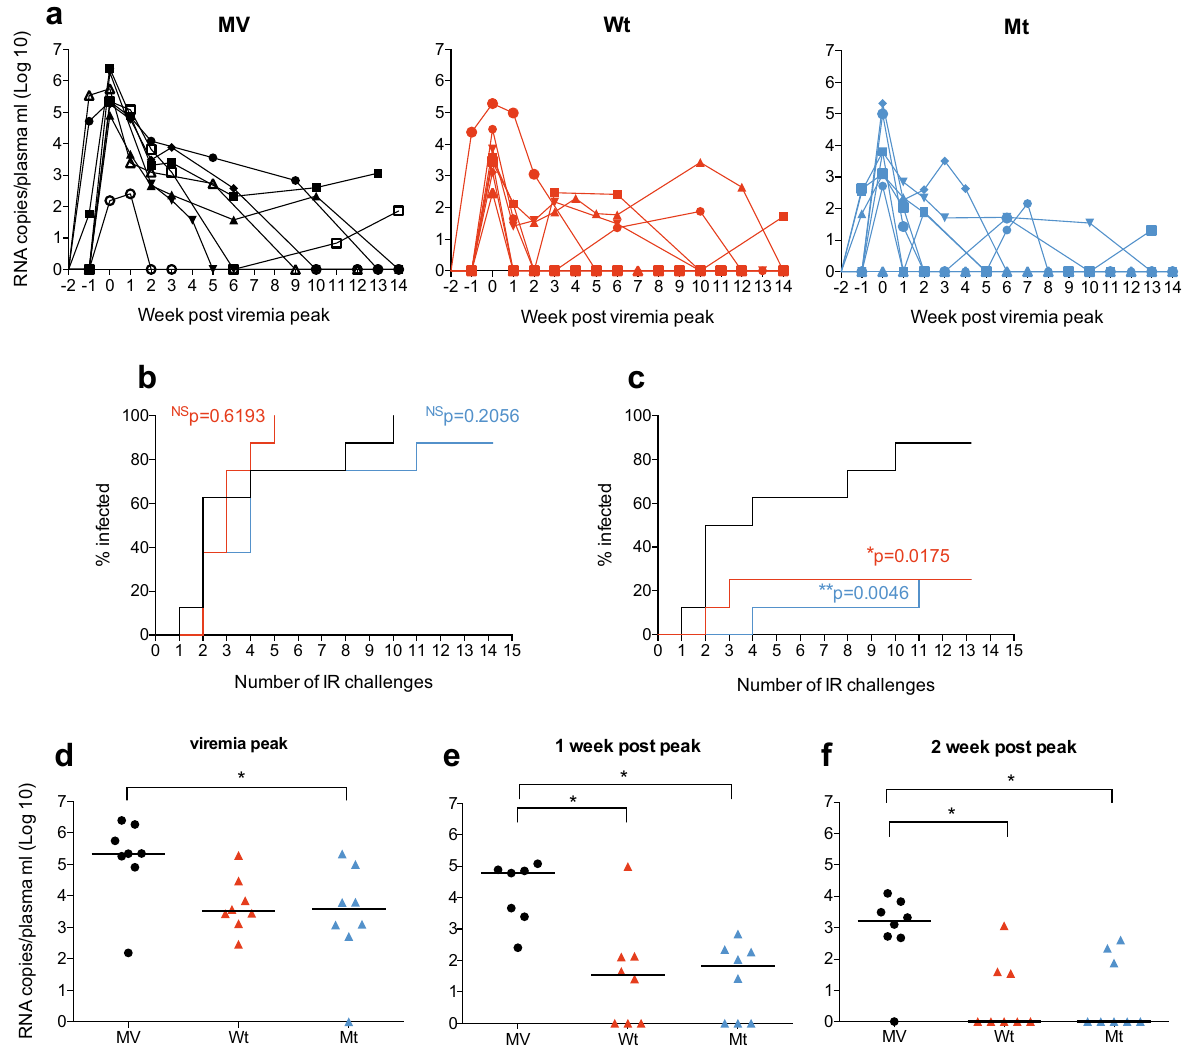
Fig. 2 Control of SHIV-SF162p3 replication in immunized animals. MV: control, Wt: MV-SHIV Wt, Mt: MV-SHIV Mt. a Longitudinal study of plasma viral load in control (MV) and vaccinated (Wt and Mt) animals starting from the week “ viremic peak -2 ” . b Percentage of infected animals after each challenge (no signi fi cant difference between the three groups). c Percentage of infected animals after each challenge with plasma viral load above 10 4 virus copies/mL ( b and c Kaplan – Meyer plots; P values are calculated by the log-rank Mantel – cox test). d Peak plasma viral load. e Plasma viral load at 1 and ( f ) 2 weeks post peak ( P values are calculated by Kruskal – Wallis and Dunn ’ s multiple comparisons tests). Group medians are plotted as a horizontal line. b – f P values: NS > 0.05, *< 0.05, **<